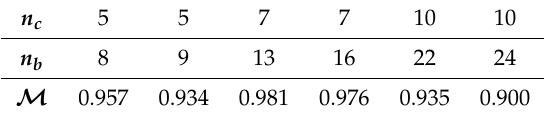
Figure 6. State diagram of the colloidal clusters in the surface coverage-cluster size plane. The symbols indicate the following states of the clusters based on the orientational order parameter: , spherical cluster; , non-spherical cluster; , clusters with randomly oriented patches. ∗ Table 1. Orientational order parameter for clusters composed of n c colloids and n b bonds for χ = M